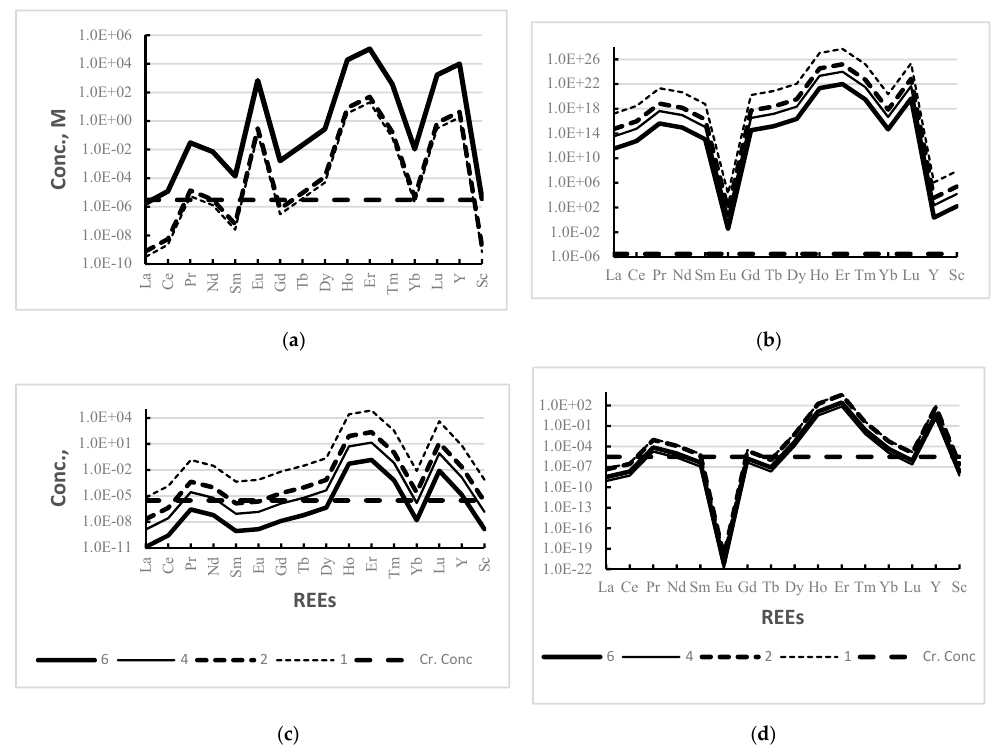
Figure 4. Concentrations of ( a ) Re 3+ , ( b ) ReCl 2+ , ( c ) Re(NO 3 ) 2+ , and ( d ) Re(SO 4 ) 2 − in equilibrium with sulfate precipitate with 10 − 4 M of total concentration of sulfate in solution at pH 6, 4, 2, and 1. Cr. Concentration: 1 ppm line as a target concentration. Additional sulfate is provided by sulfuric acid in ( a ) and ( d ).